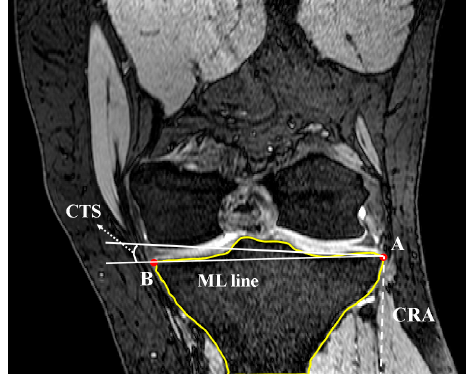
Figure 9. Calculation of coronal tibial slope in interested MRI slice as the angle between ML line and the perpendicular line of CRA (coronal view).